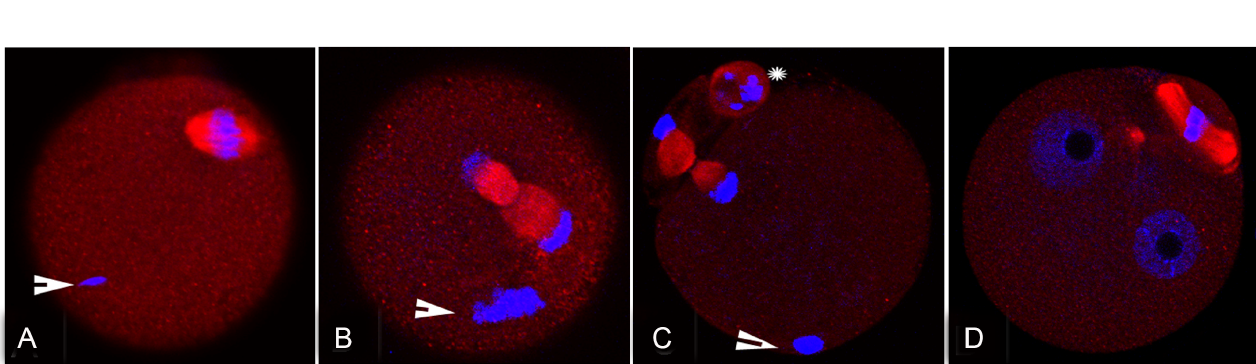
Fig 1. Protein expression of RGS2 in oocytes during maturation in vitro. RGS2 protein expression in mature GV (A), GVBD (B), metaphase I (C), and metaphase II (D) oocytes. RGS2 protein was initially present in the GV ooplasm (A), and 2 h after GVBD it was localized near condensing chromosomes (B). During the first meiotic division, RGS2 accumulated on the spindle (C). In metaphase II oocytes, RGS2 could be observed on the microtubules of spindles and the first polar body (D). Nuclei were stained in blue and RGS2 is shown in green. Scale bar, 20 μ m.